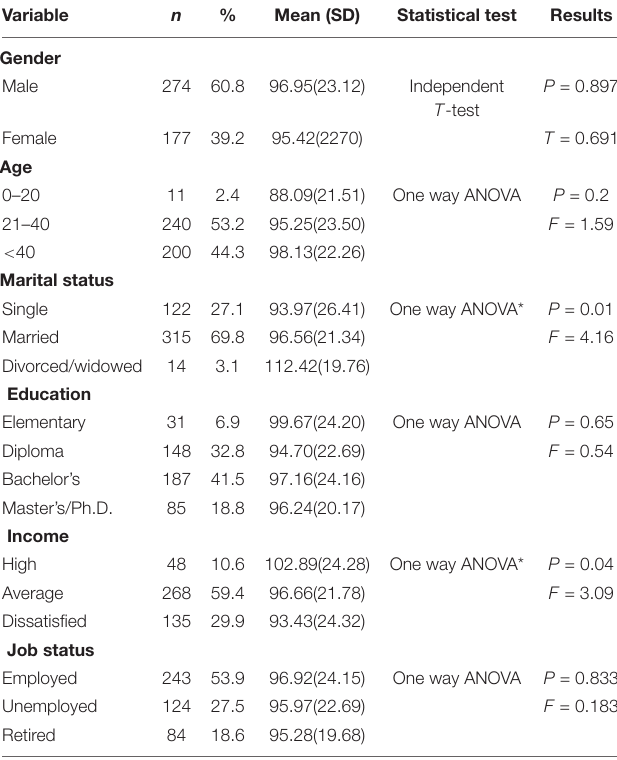
TABLE 1 | Mean score of quality of life, based on demographic